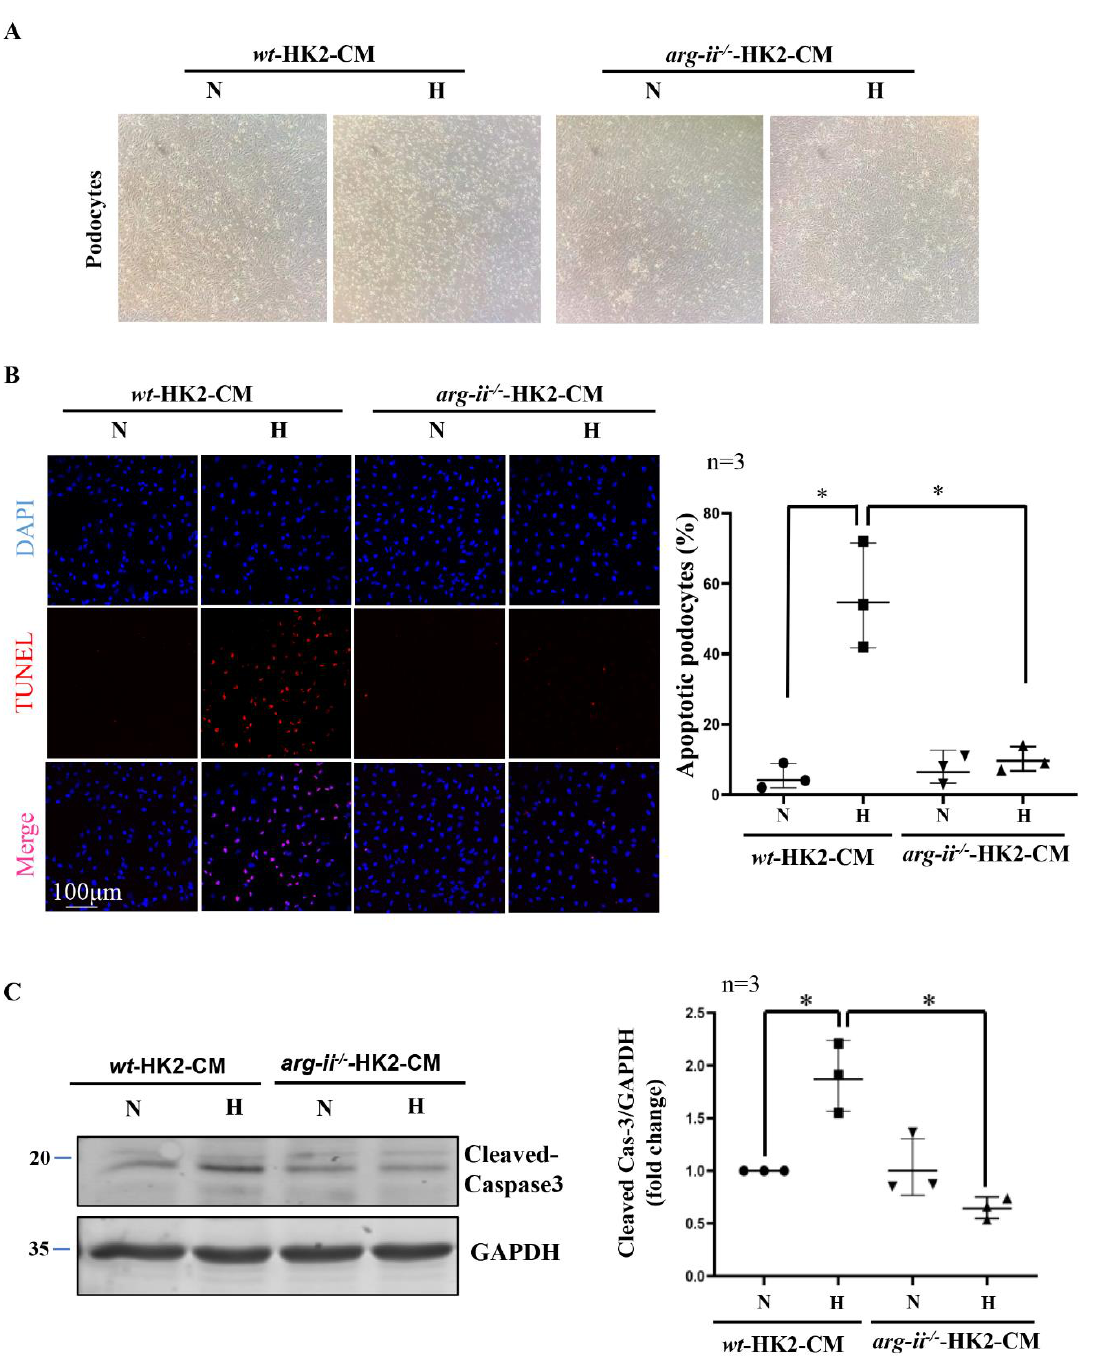
Figure 2. Arg-ii deficiency in human renal epithelial cells prevents hypoxia-induced paracrine effects of the cells on podocyte apoptosis. ( A ) Representative images showing cell morphology in different groups of podocytes. ( B ) Representative images of TUNEL staining in human podocytes. Nuclei